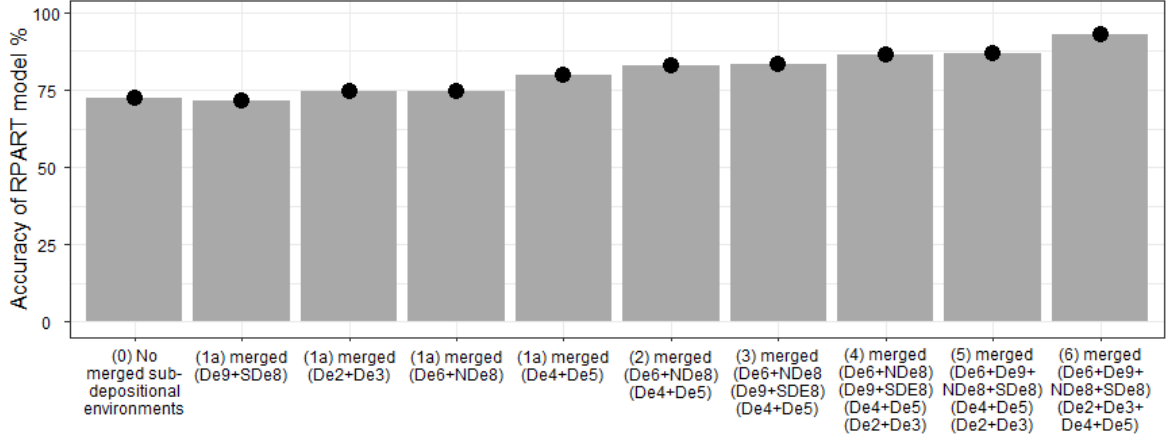
Figure 10. Bar chart showing model accuracy for different approach of classification trees. High model accuracy was achieved by engineering the datasets, through selective merging of neighbouring sub-depositional environments.